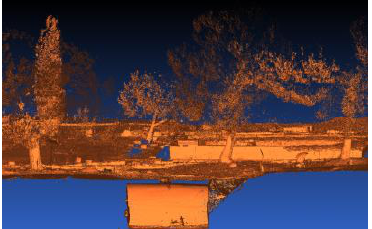
Figure 4. The underground water holding tank Mesh